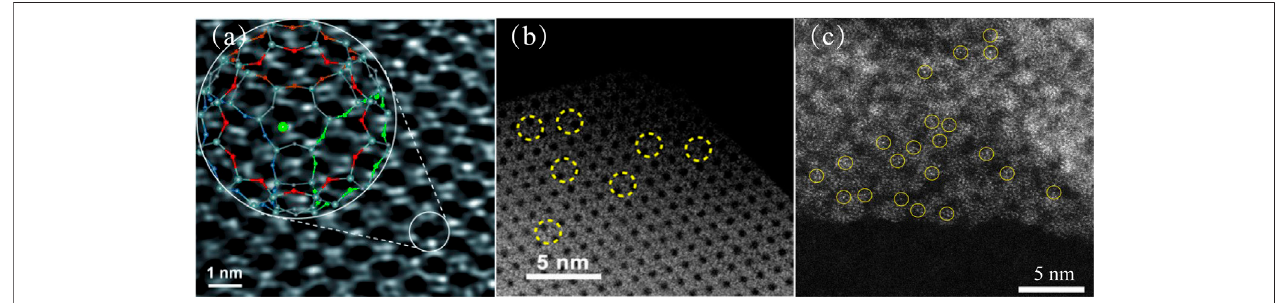
FIGURE 1 | (A) Aberration-corrected HAADF-STEM images of the sample prepared by adsorption of Au(CH 3 ) 2 (acac) in zeolite NaY (Lu et al., 2012). Copyright 2012, Wiley. (B) AC-HAADF-STEM images of Ru SAs/S-1 (Qiu et al., 2019). Copyright 2019, American Chemical Society. (C) HAADF-STEM image of Pt - SA - Ce - MOF shows that Pt atoms (in yellow circle) were uniformly dispersed in the Ce - MOF support (Guo et al., 2020). Copyright 2020, American Chemical Society.